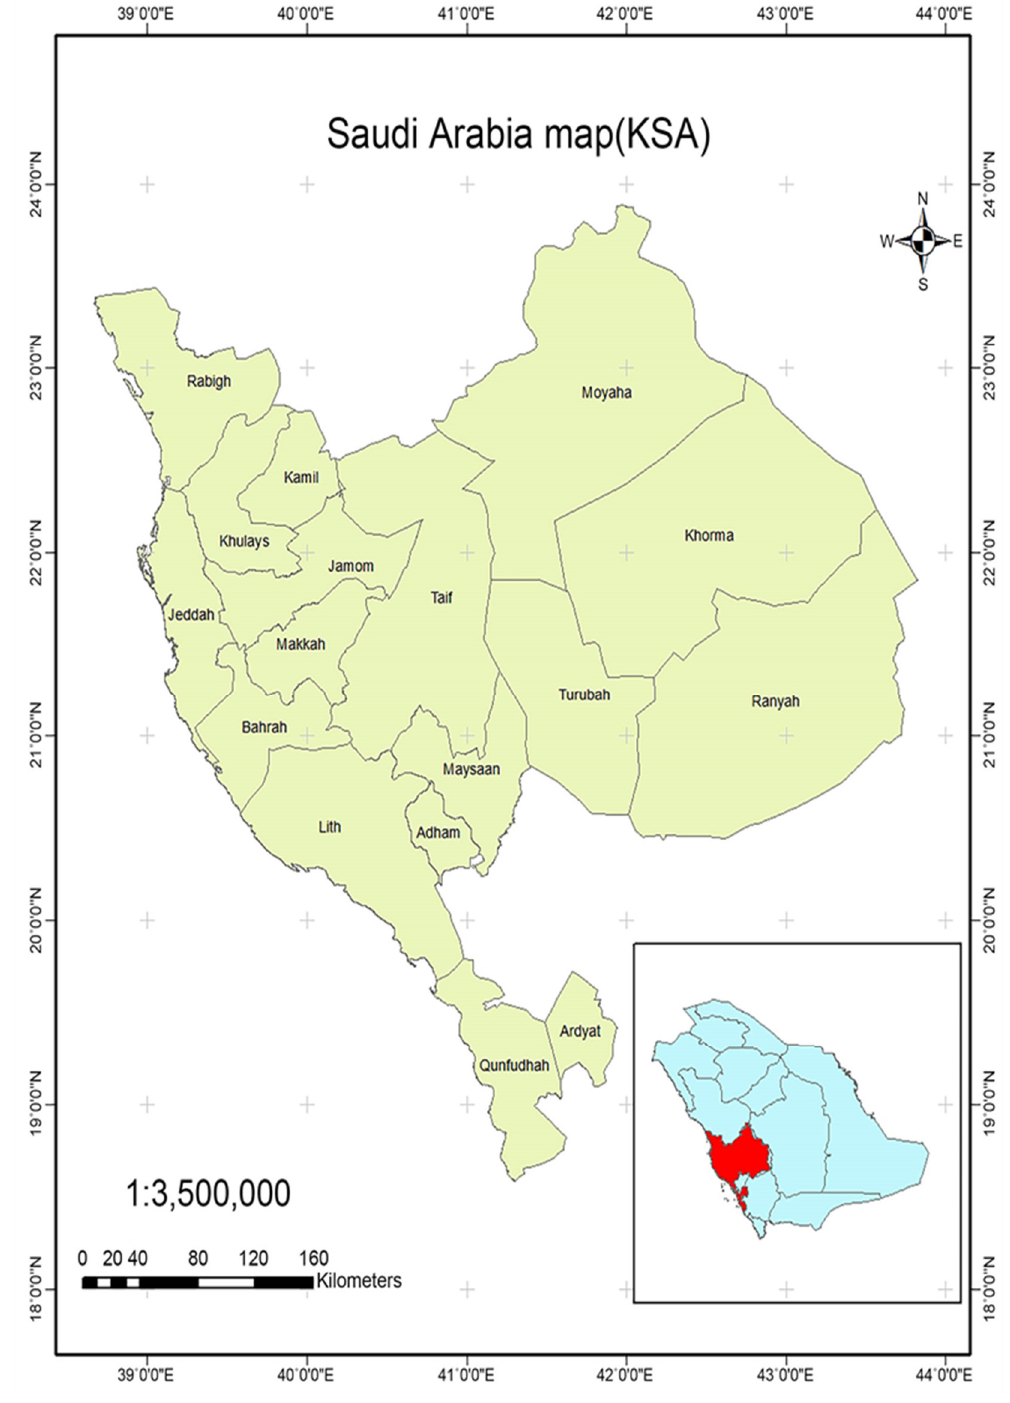
Figure 2. Mecca governorate map [8].